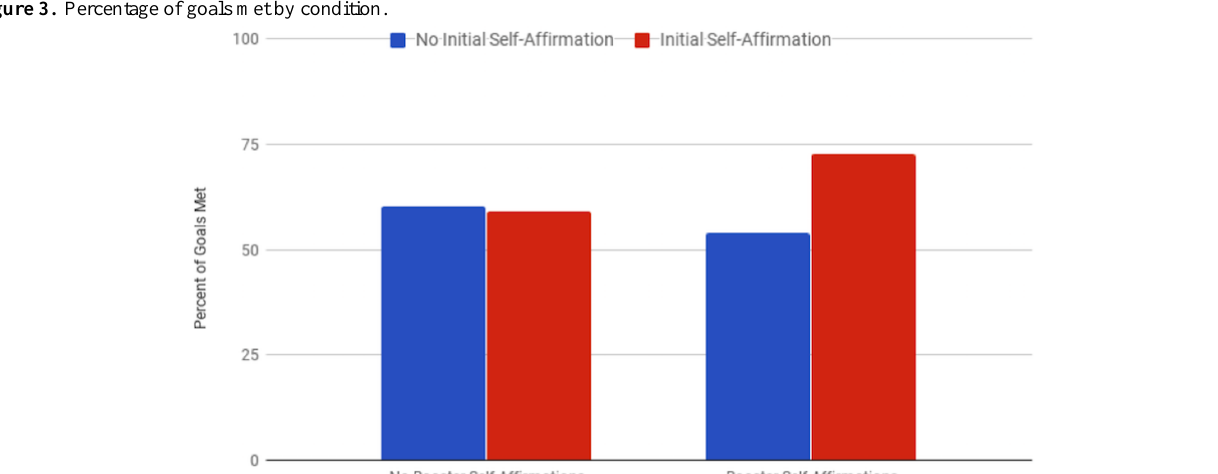
P value z valueSECoefficient estimateCoefficients